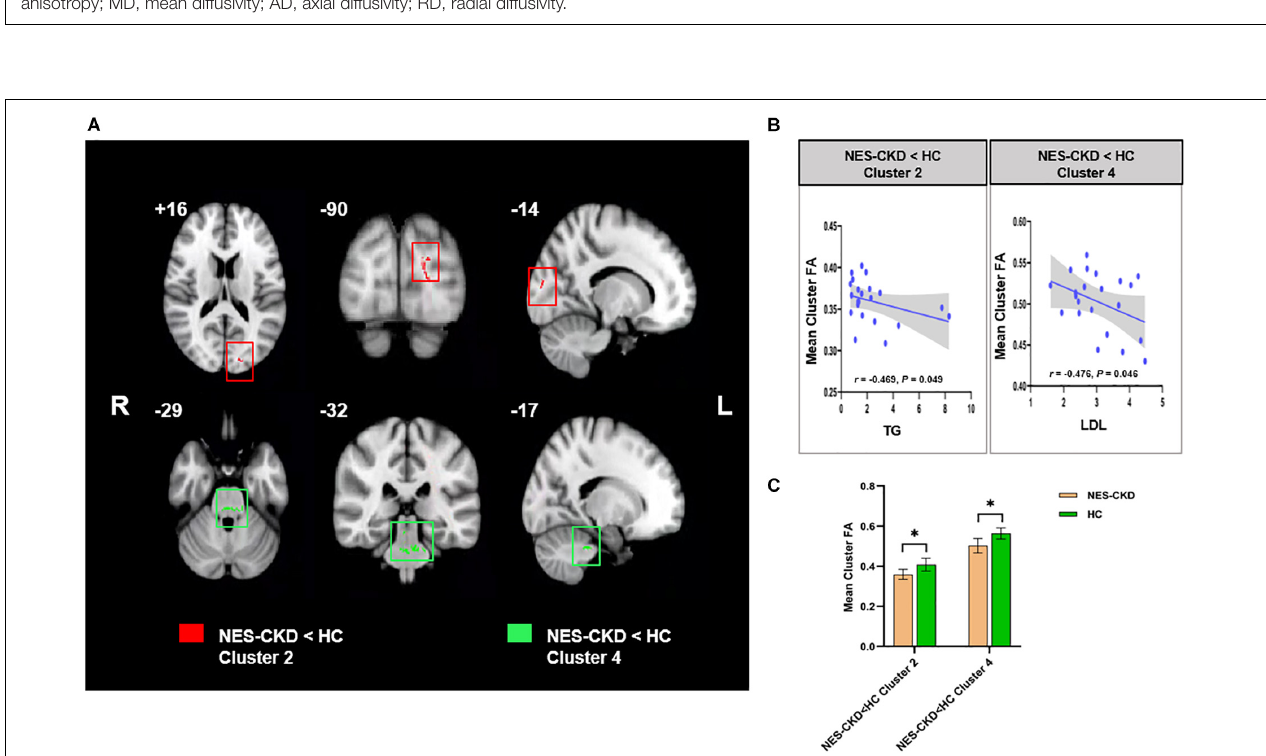
FIGURE 4 | (A) Biochemical tests relevant clusters with statistically significant FA differences obtained from the NES-CKD and HCs. Cluster 2 is marked in red and Cluster 4 in green. (B) Relationship between mean cluster FA and TG (left) and LDL (right). (C) The bar plots represent the corresponding mean FA for each group. NES-CKD, non-end-stage chronic kidney disease; HC, healthy control; FA, fractional anisotropy. * indicates a statistical difference between the two groups, p < 0.05.